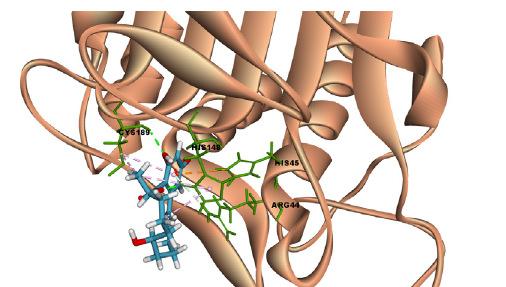
Fig. 4B. 3D diagram showing interactions of a -Zeara- lenol at LGMN catalytic site.